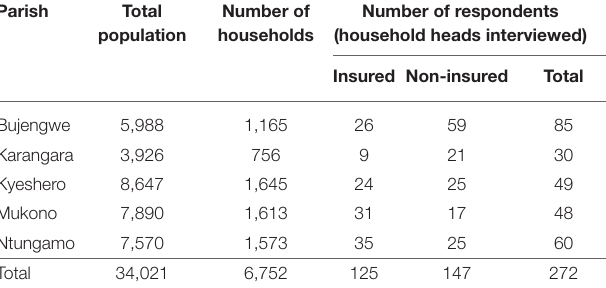
TABLE 1 | Distribution of respondents by parish in Kayonza Subcounty.